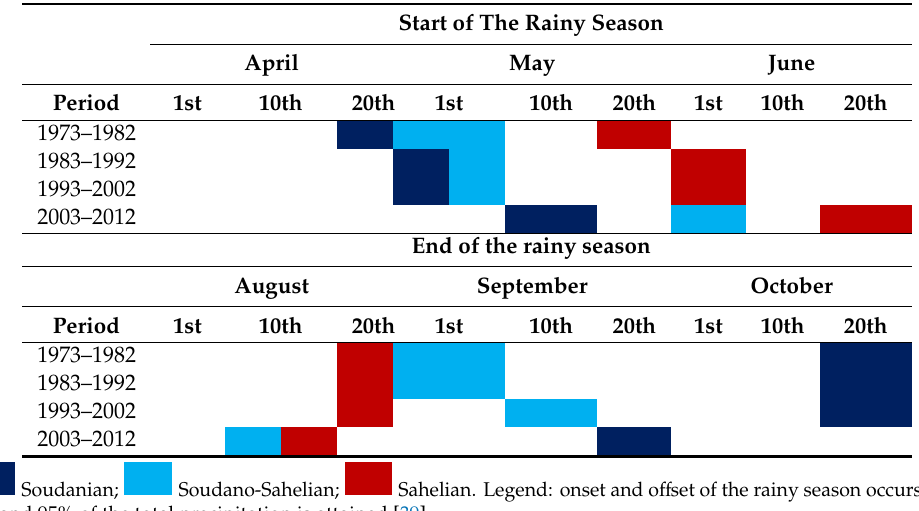
Table 6. Changes to average onset and offset of the rainy season along the different agroclimatic zones (Soudanian, Soudano-Sahelian, and Sahelian) for the period 1973–2012. Start of The Rainy Season